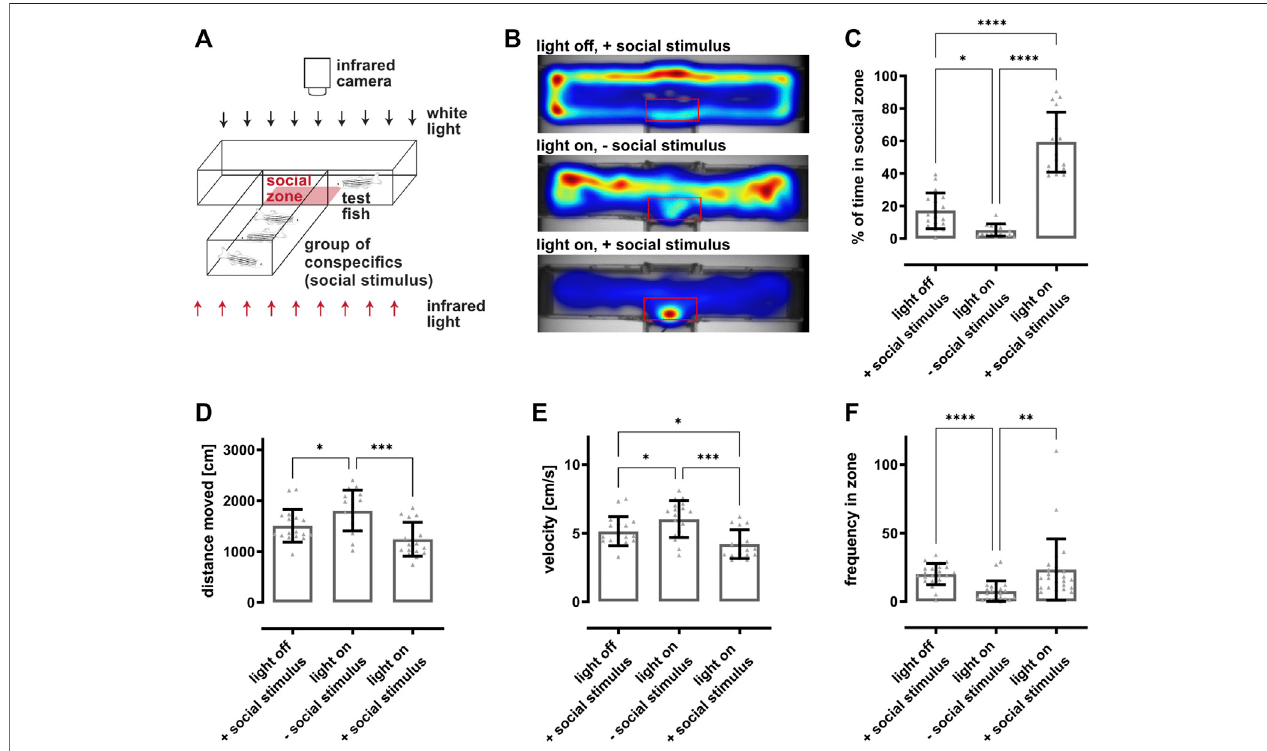
FIGURE 2 | Social preference behavior is dependent on vision. (A) Scheme of the social preference setup. A custom-made T-shaped arena is divided into two completely separated compartments. The lower arm harbors a group of eight fi sh representing the social stimulus, whereas a single test fi sh is placed into the upper, perpendicular arm. A transparent window is the only non-opaque interface between the two compartments. The movement of the test fi sh within the compartment is recordedfromthetopusinganinfrared-sensitivecameraand aninfrared lightsourceplacedbeneath. Thezoneinfrontofthewindow isde fi nedassocialzone (red box) andused for quanti fi cations. (B) Representativeheatmaps indicate thetest fi sh ’ spositioninthe compartment asafunction ofthecondition. In darkconditionsand in presence of a social stimulus (light off, + social stimulus), fi sh stayed in close proximity to the borders of the compartment. In illuminated conditions and absence of a socialstimulus(lighton, − socialstimulus), fi shwerefreelyroaming withinthewholecompartment.Incontrast,inilluminated conditionsand presenceofasocialstimulus (light on, + social stimulus), fi sh spent a signi fi cant amount of time within the social zone. (C) Quanti fi cation of the time spent in the social zone revealed that fi sh spent signi fi cantlylesstimeinthesocialzoneindarkconditions(17.1 ± 10.6%)orinilluminated conditionsintheabsenceofasocialstimulus(5.3 ± 3.7%)ascompared tolight onconditionswithasocialstimulus(59.3 ± 17.9%). (D) Quanti fi cationofthedistancemovedshowedthat fi shswamslightlymoreinilluminatedconditionsintheabsence of a social stimulus (1804 ± 387 cm) in comparison to dark conditions (1507 ± 313 cm) or illuminated conditions with a social stimulus present (1243 ± 321 cm). (E) Quanti fi cation of the velocity revealed that the test fi sh swam faster in illuminated conditions in the absence of a social stimulus (6 ± 1.3 cm/s) compared to